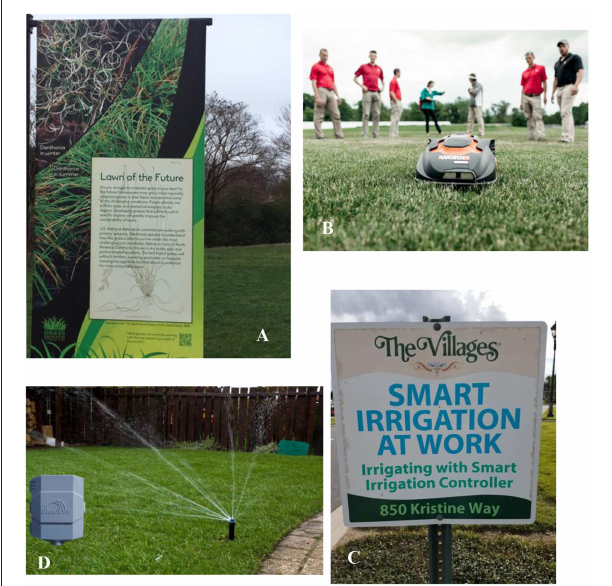
FIGURE 4 | The future of urban grasslands in the U.S. is rapidly changing with adoption of resource conserving technologies and environmental regulatory practices. Examples of changing practices aimed to promote more sustainable management of urban grasslands: (A) development of new lawn cultivars that are drought tolerant and require less maintenance, sign displayed at the Grass Roots Initiative exhibit at the National Arboretum in Washington DC; (B) autonomous, battery-powered lawn mower evaluations at the Cornell University Turf and Landscape Research and Extension Center in Ithaca, NY; (C) signage explaining the Smart Irrigation System installed in an expanding residential community in Florida; and (D) wireless, sensor-based irrigation network. Photos by: (A) Jenny Kao-Kniffin, (B) Justin James Muir, courtesy of Cornell CALS, (C) Shirley Kniffin, and (D) BlueSpray, Avidz LLC. Written consent was obtained for all photo